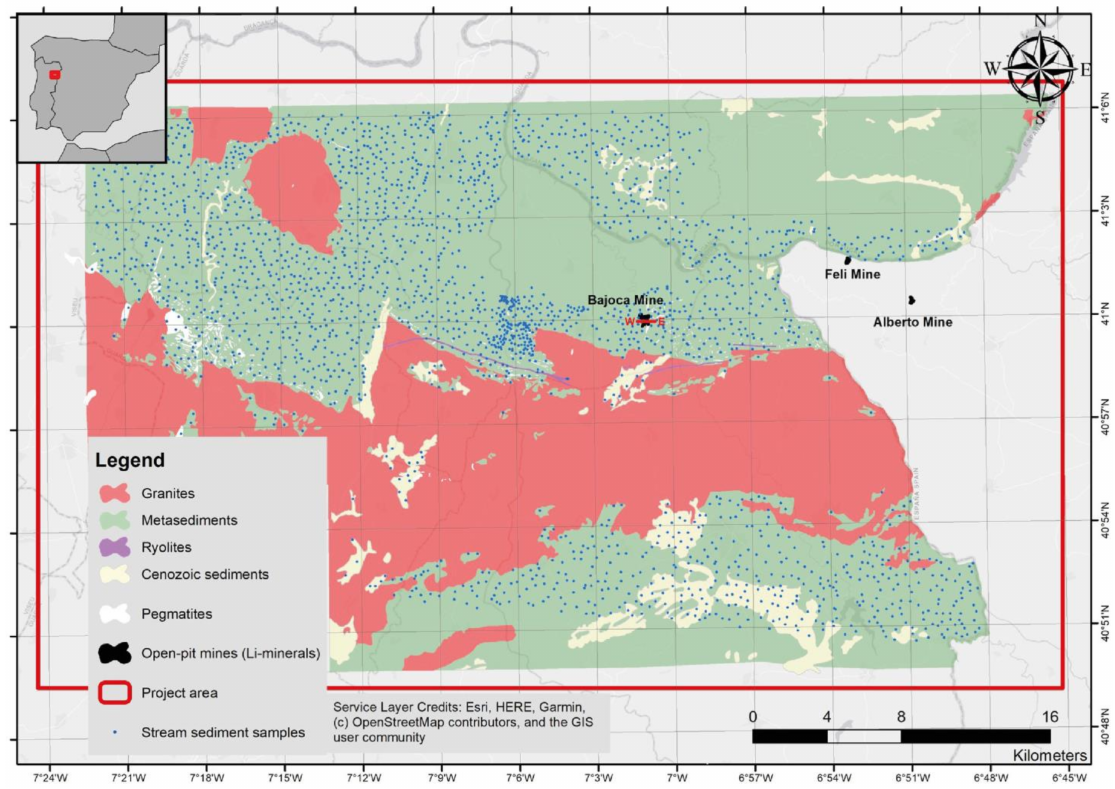
Figure 1. Extent of the simplified digitised geological maps, open-pit mines exploiting Li minerals, and the stream sediment data within the study area in NE Portugal (Coordinate System: Lisboa Hayford Transverse Mercator, Projection: Transverse